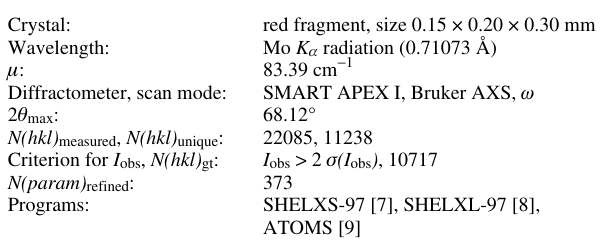
Table 1. Data collection and handling.